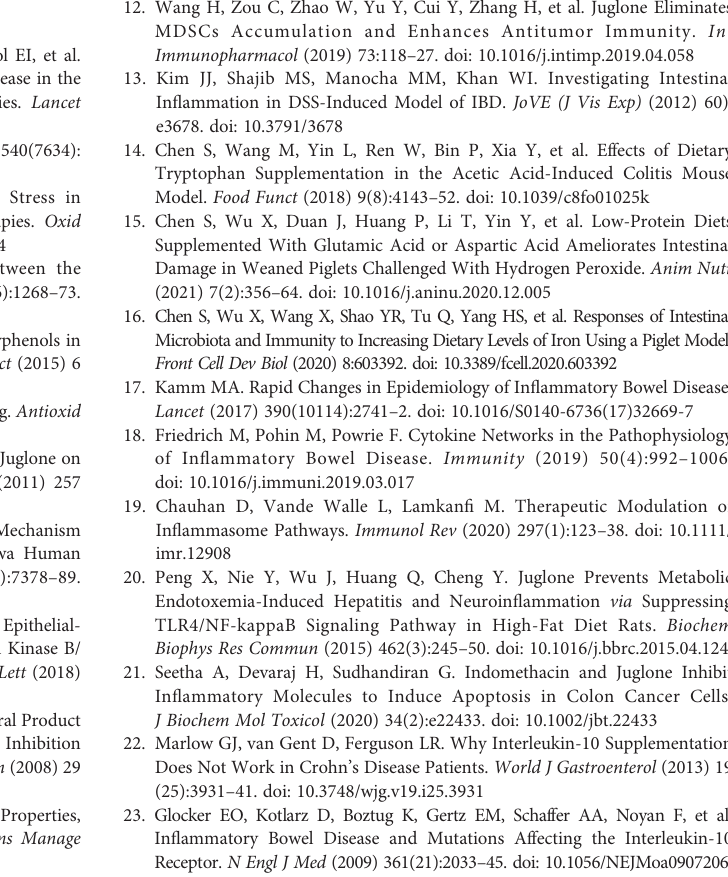
Supplementary Table 1 | DAI score protocol. DAI score was used to evaluate colitis ’ s clinical activity, and it was the total sum of body weight loss score, stool consistency score, and bloody stools